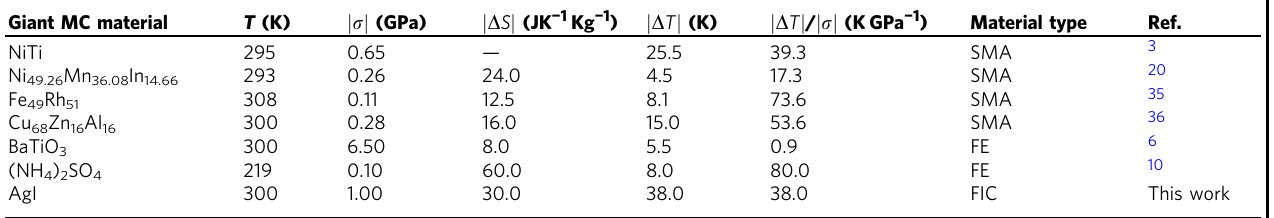
Table 1 Giant mechanocaloric (MC) effects near room temperature Giant MC